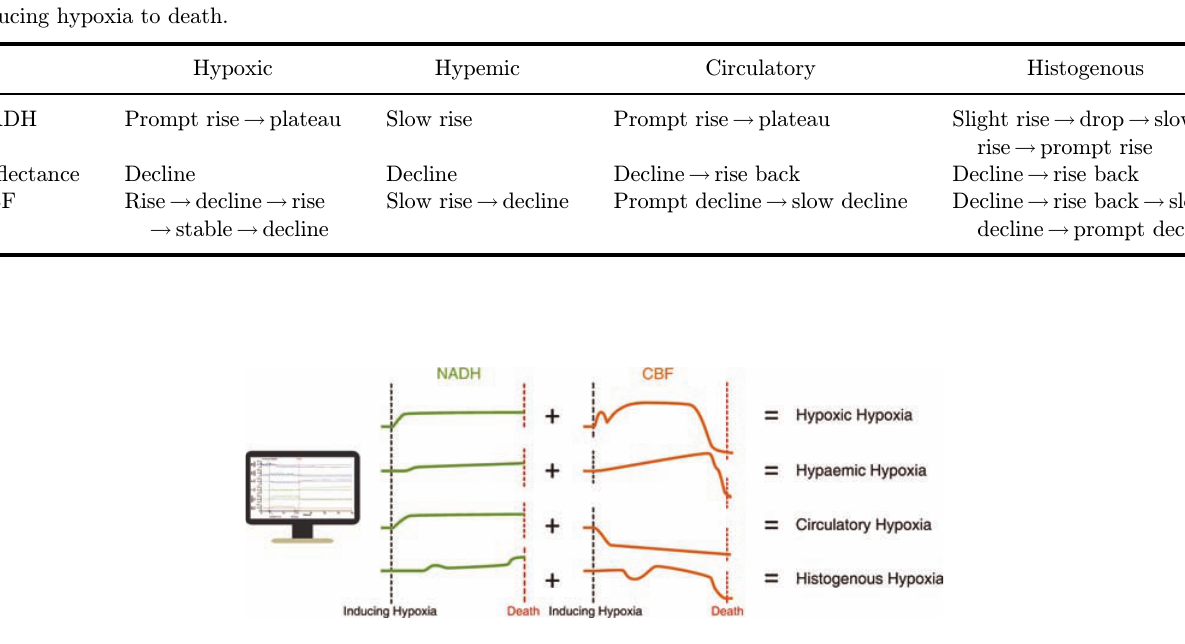
Fig. 5. The combination of the change of NADH and CBF helps in the identi¯cation of acute hypoxia causes. The change patterns of NADH and CBF were characterized from the four groups of animals.